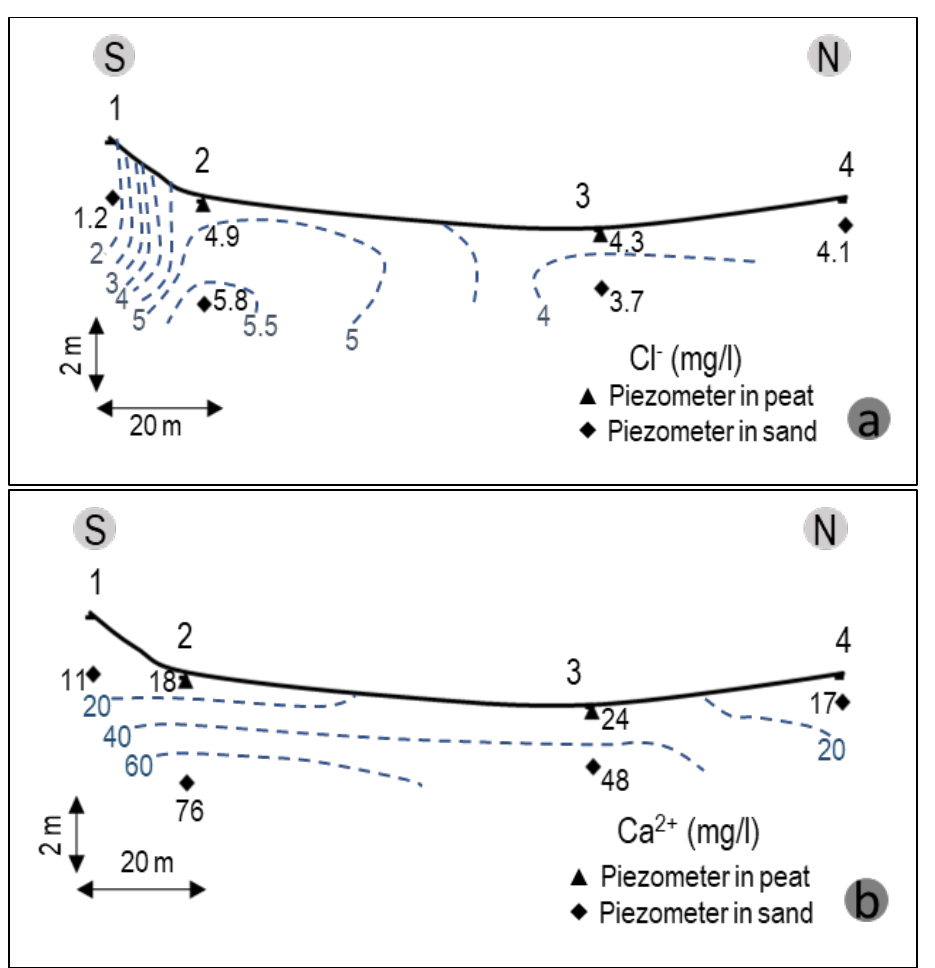
Figure 4. Isohypses of (a) chloride and (b) calcium concentrations in mg L -1 along the Peterezera inter-dune transect.